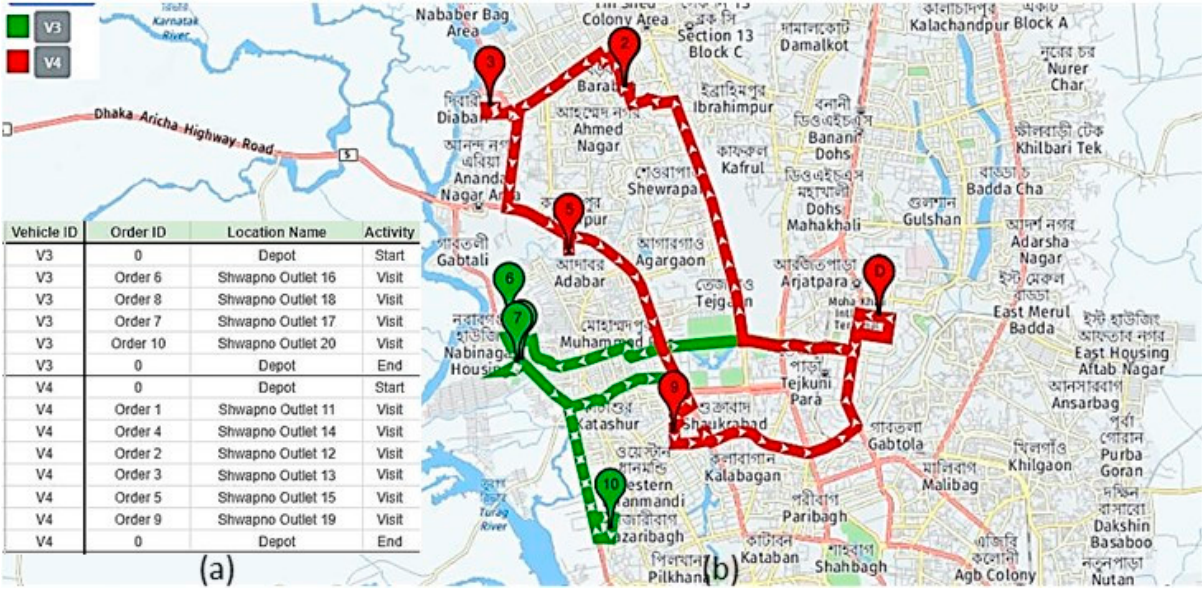
Figure 7. ( a ) Scheduling ( b ) Navigation sequencing of vehicles 3 and 4 in Region-2. Internet and mobile applications significantly influence the transportation